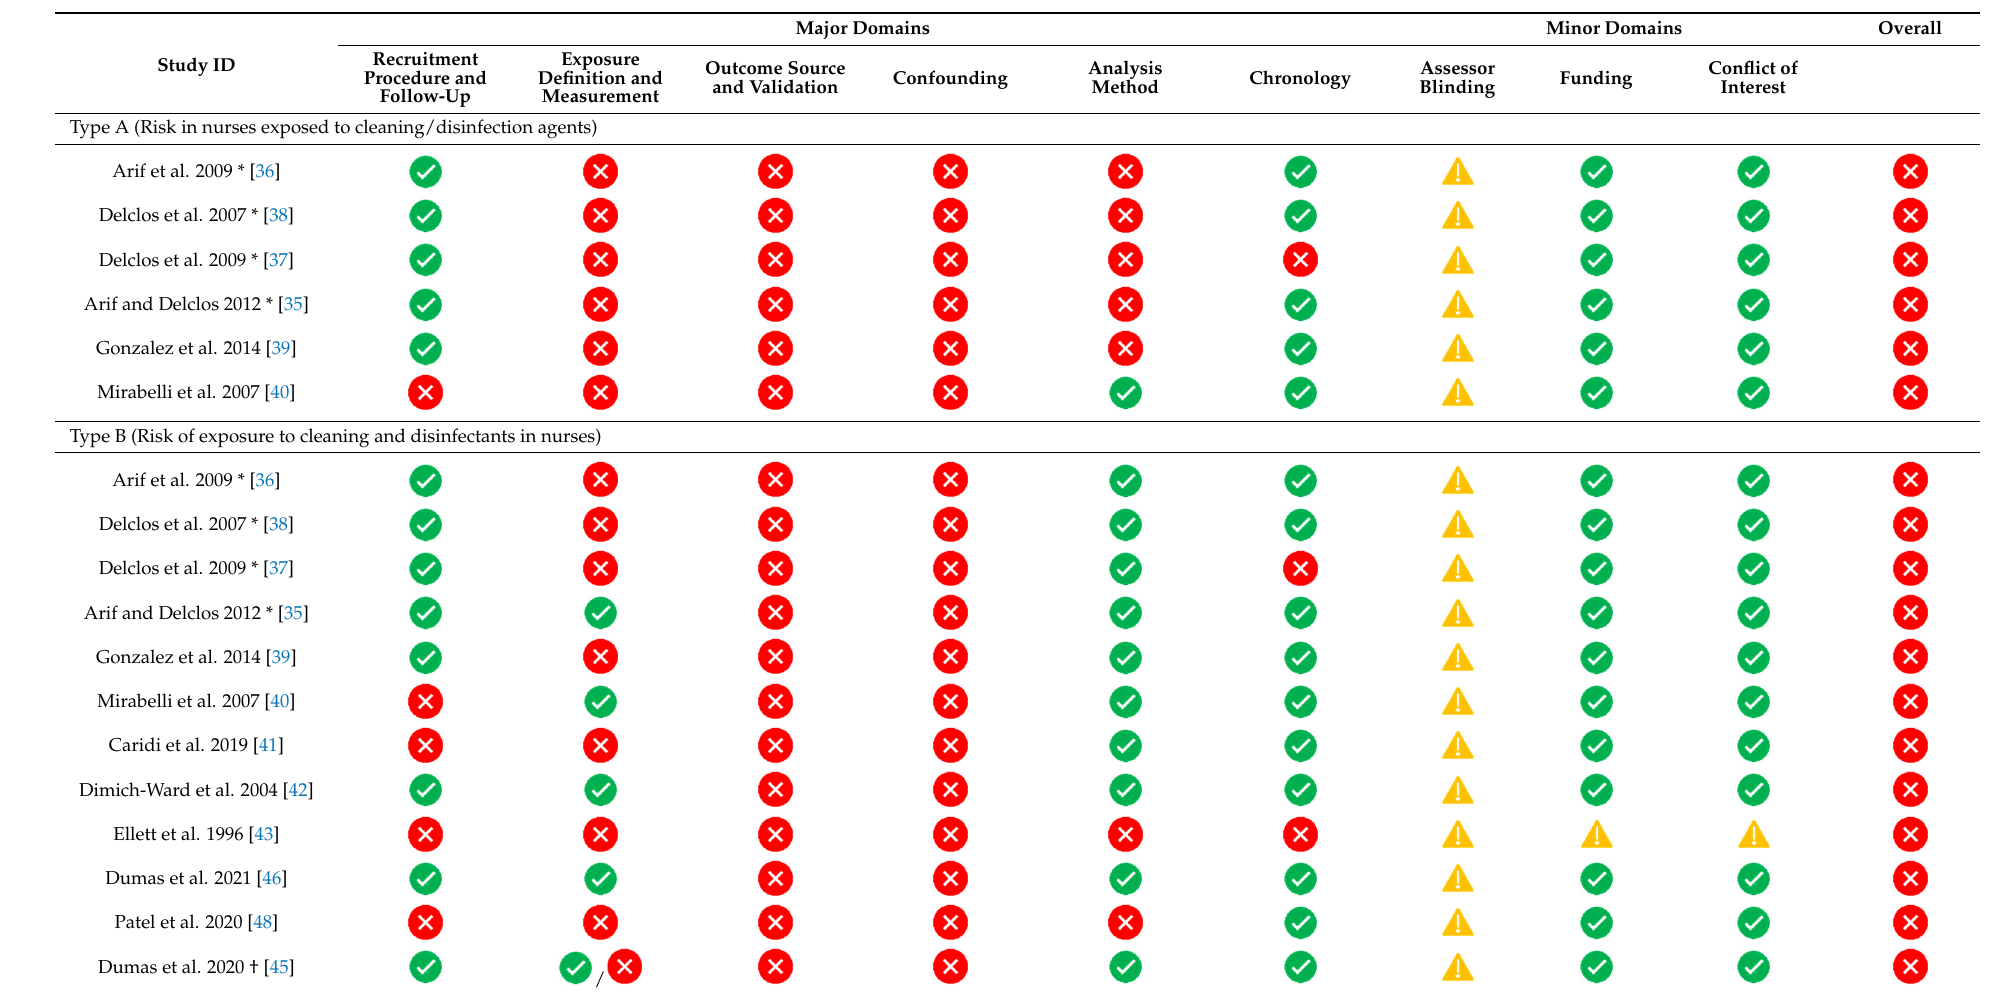
Table 2. Risk of bias for asthma studies.